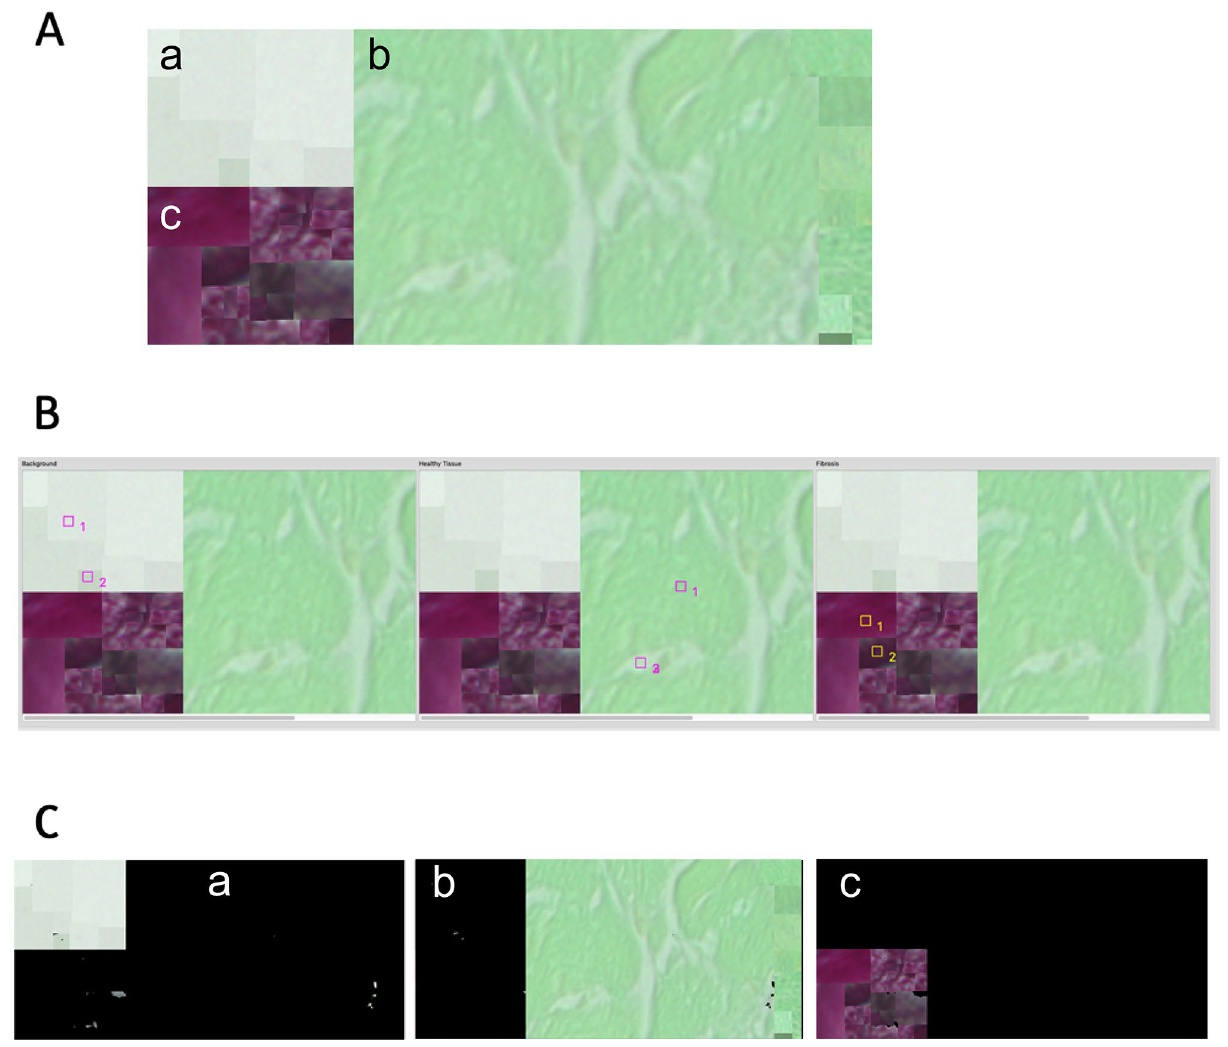
Figure 3. Schematic representation of the workflow and analysis process within the quantification